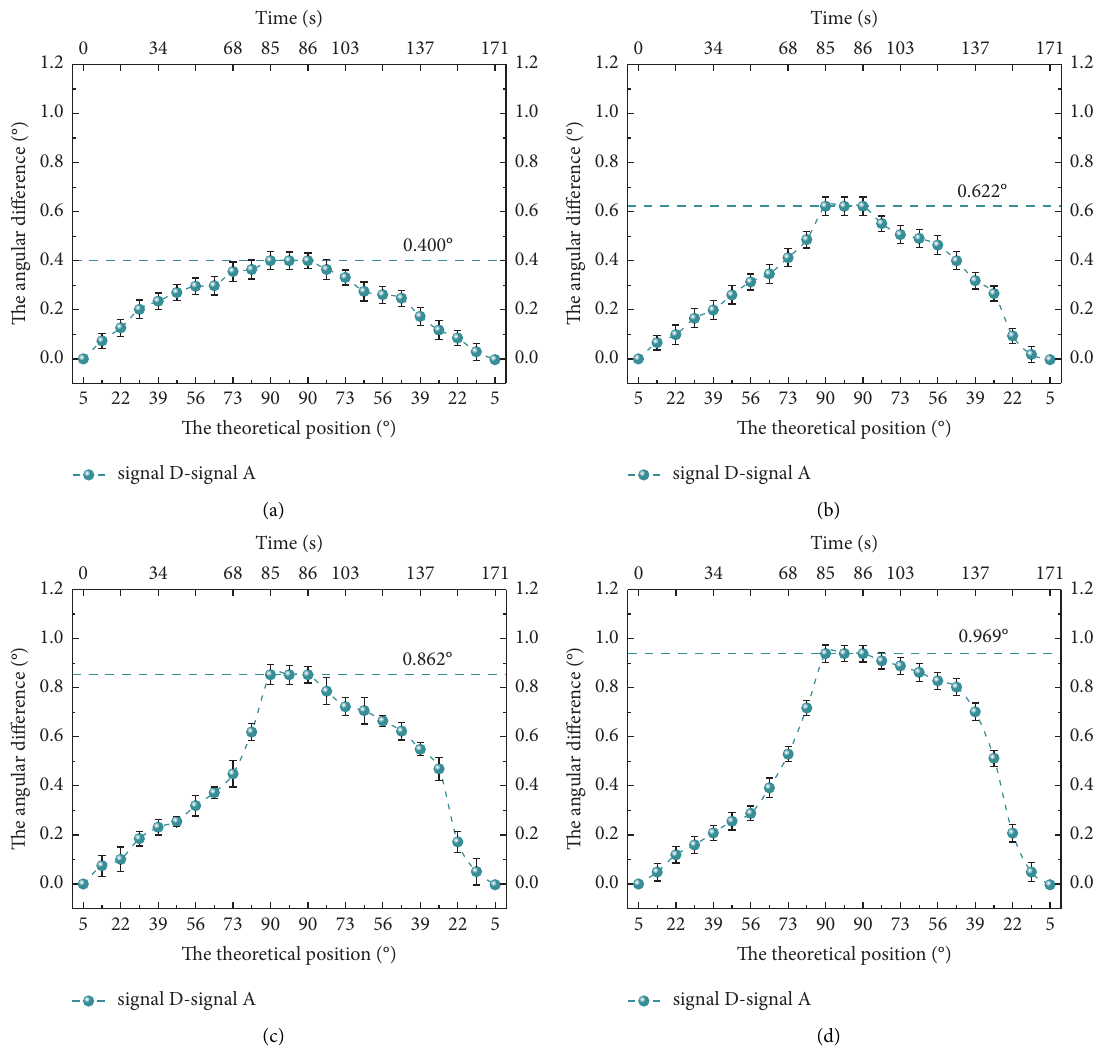
Figure 14: Te angle diference of diferent backlashes. (a) y J min � 0.84 mm; (d) y 2 � 1.5mm, J min � 1.26mm.